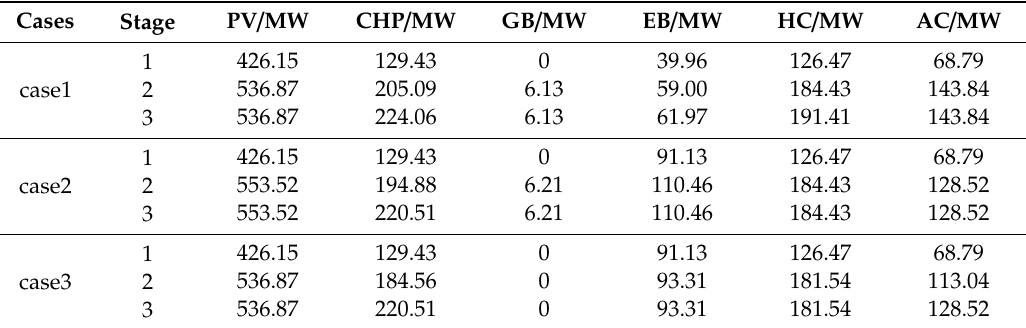
Figure 8. Regret value under di ff erent planning methods. Table 8. Typical device expansion planning under di ff erent planning methods. Table 9. Regret value under multiple scenarios with different planning methods